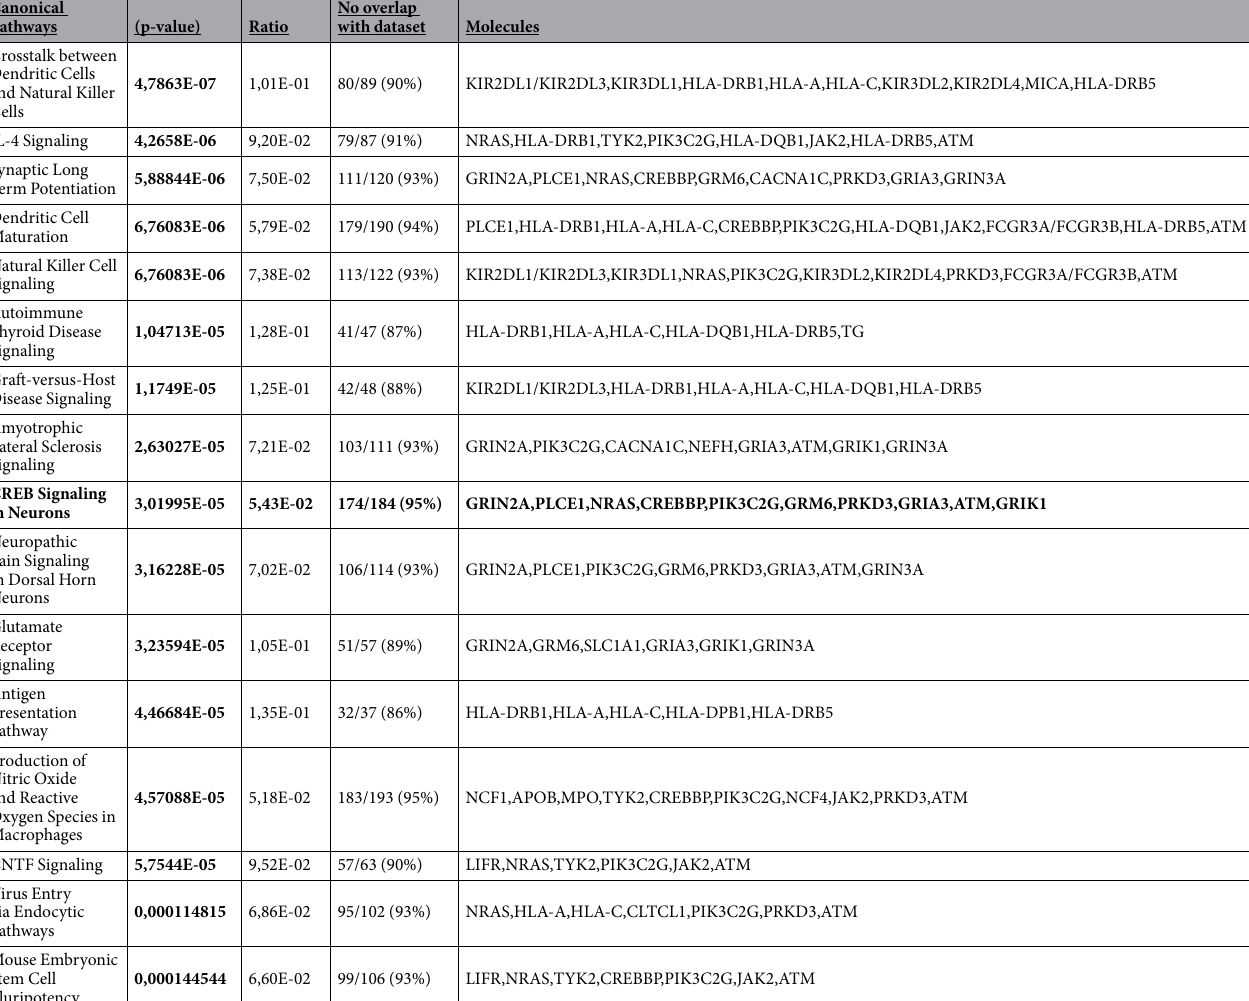
Table 1. Export of Ingenuity Pathway Analysis of 229 genes with at least one damaging mutation showing the top 16 most significant Canonical Pathways across the entire dataset. The significant values for the canonical pathways are calculated by Fisher’s exact test right-tailed. The ratio is calculated by the number of genes from the analysis list (229) in the given pathway, divided by the total number of genes that make up that pathway. All molecules involved are shown in the last